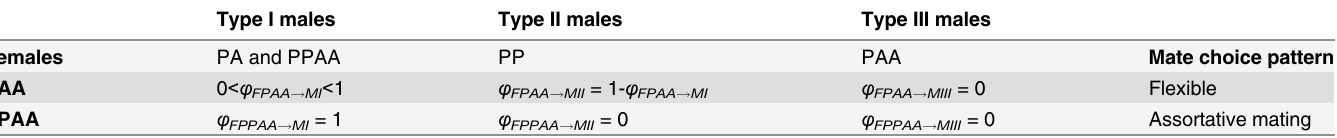
Table 1. Preferences of PAA and PPAA females towards type I, type II and type III males simulated in the model. The preferences of PAA females consist in a flexible mate choice pattern because it includes a certain degree of preference towards both type I and type II males, whereas PPAA females only favor type I males for mating. Note that PPAA females also produce offspring of their own genomotype in crosses with PA males (see text for further